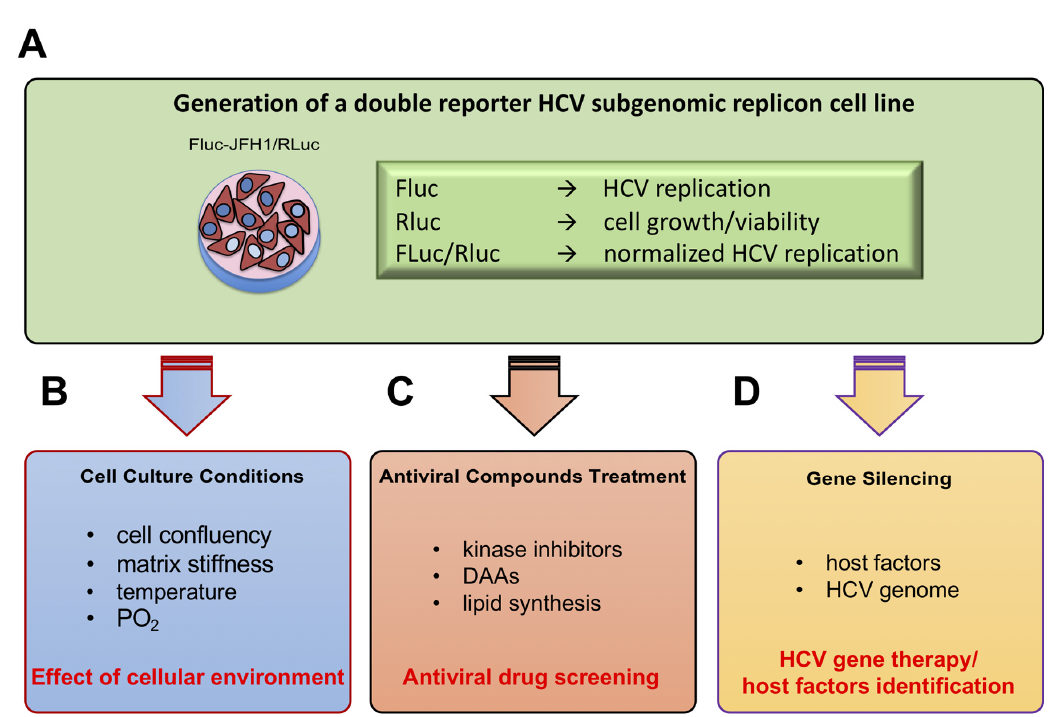
Figure 7. Schematic representation of the study experimental set up. ( A ) We established a double reporter HCV replicon cell line allowing simultaneous luminometric quantification of HCV genotype 2a JFH1 replication (FLuc) and cell proliferation / viability (RLuc). Such cell line can be used for several applications including: testing the e ff ect of cell culture conditions on HCV replication ( B ), antiviral compounds identification / screening ( C ), or gene silencing experiments aimed at identifying new host factors, as well as optimization of conditions for therapeutic gene silencing ( D